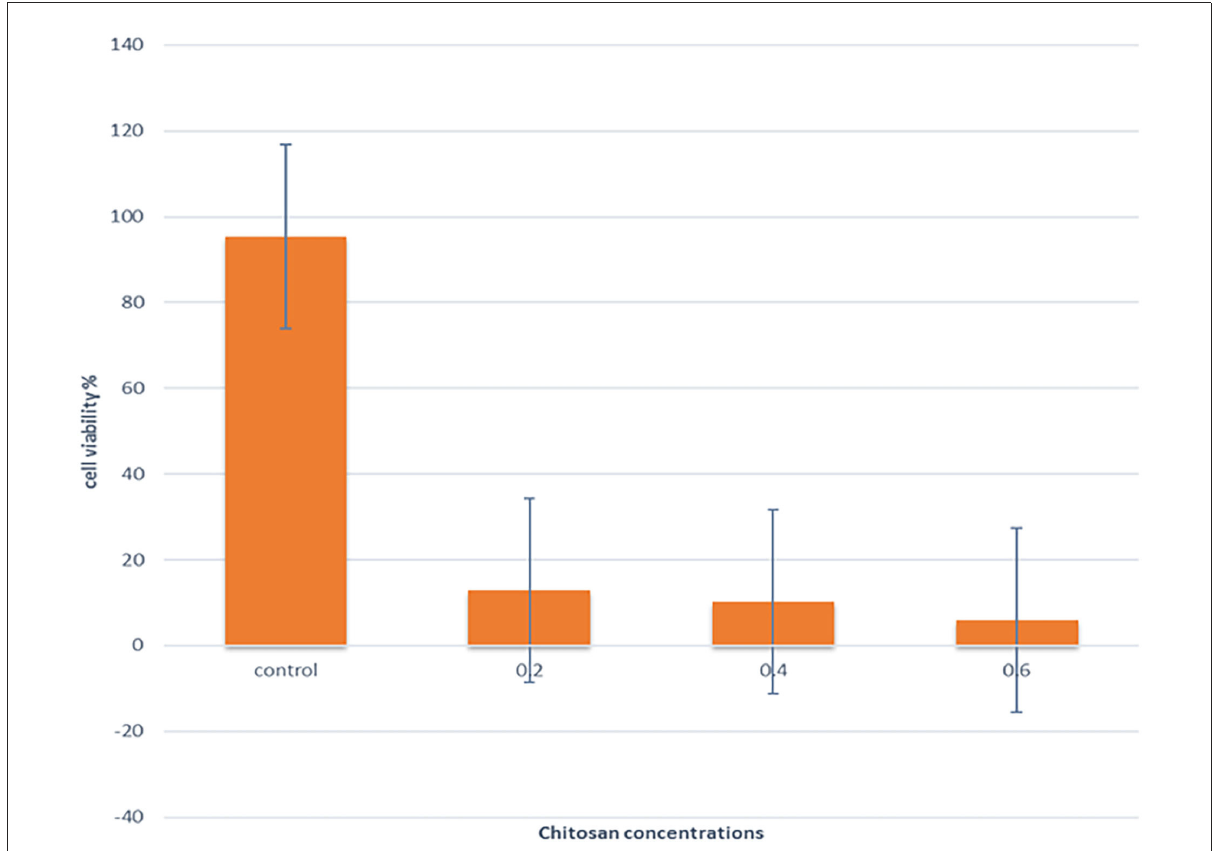
FIGURE6 The effect of different concentrations of CS on the viability of the HeLa cell line was assessed by